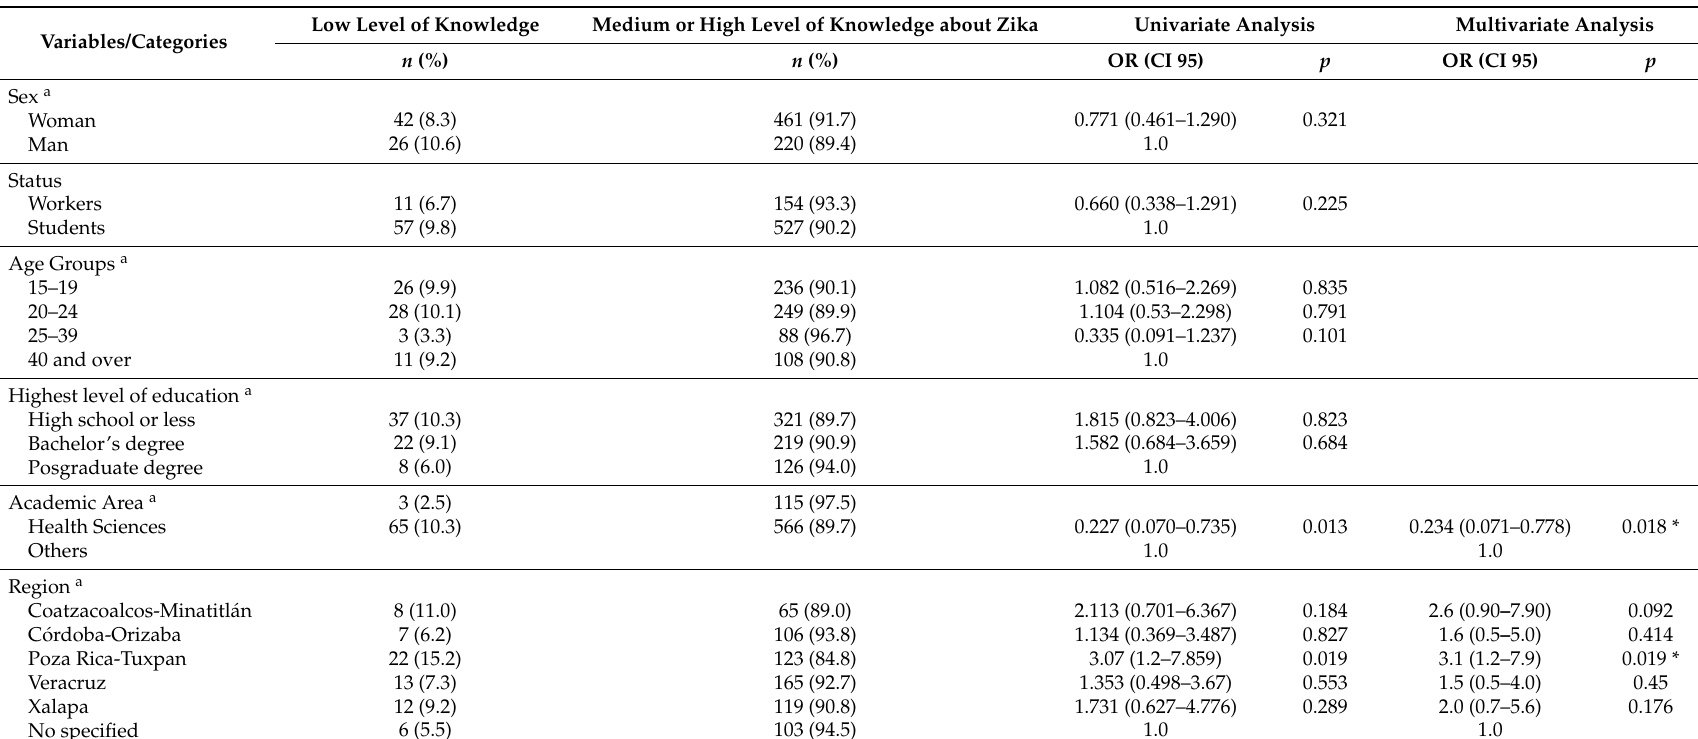
Table 3. Predictors of general knowledge about Zika by applying both univariate and multivariate